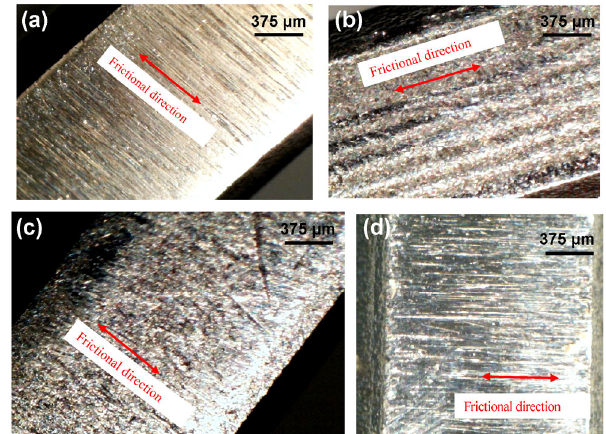
Fig. 11 Photomicrographs of the surface of the piston ring specimen tested using (a) lubrication without abrasives, (b) lubrication with sand particles of size 0–80 µm and a concentration of 10 g/L, (c) lubrication with sand particles of size 0–80 µm and a concentration of 4 g/L, and (d) lubrication with sand particles of size 0–80 µm and a concentration of 8